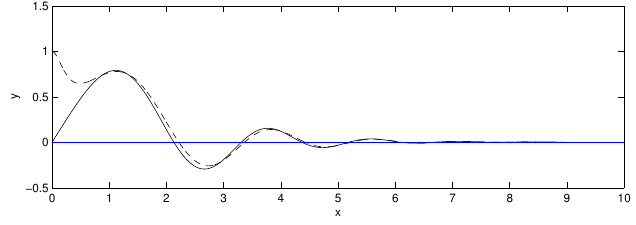
Figure 4. Fractional oscillations as in (3.14) with y (0) = 0, y (cid:48) (0) = 1, α = 0 . 75, λ = − 2 and q ( x ) = x with exact solution (solid line) and asymptotic approximation